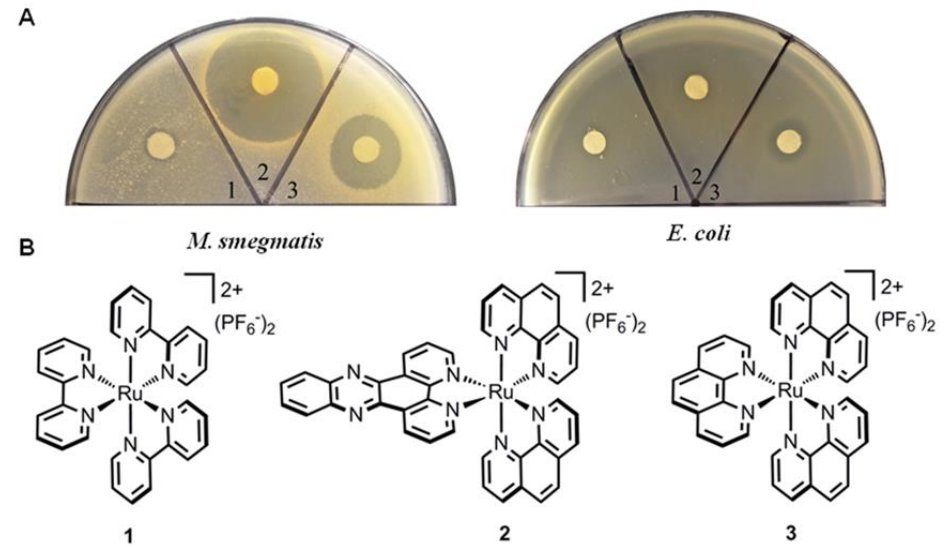
Figure 2. Antimicrobial activities of octahedral ruthenium complexes. ( A ) Strains including E. coli ATCC25922 and M. smegmatis mc2155 were used as indicator strains; ( B ) chemical structures of complexes ( 1 – 3 ) (reproduced from Reference [52]).